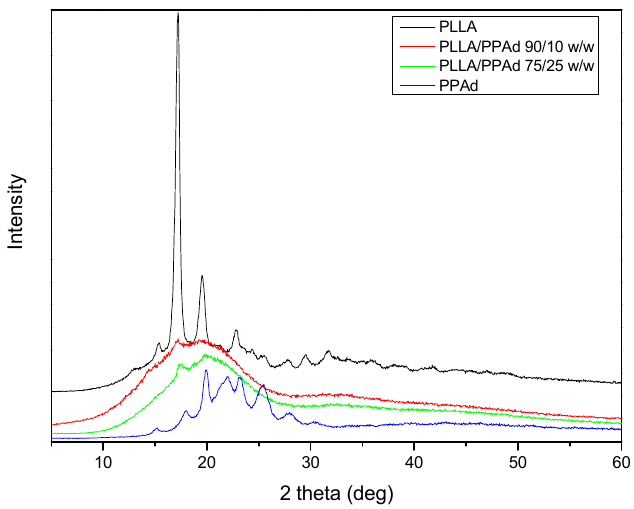
ff raction patterns of the synthesized Figure 5. X-ray diffraction patterns of the synthesized polyesters. Figure 5. X-ray di